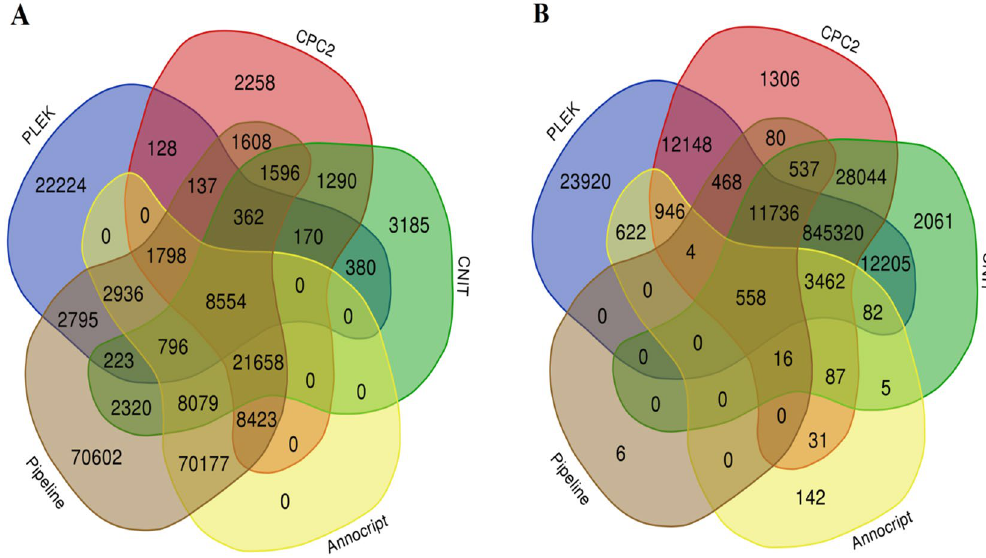
Figure 3. Performances of PLEK, CPC, CNIT and Annocript on scorpion dataset. ( A ) The fraction of scorpion dataset classified as protein-coding transcripts. ( B ) The fraction of scorpion dataset classified as non-coding